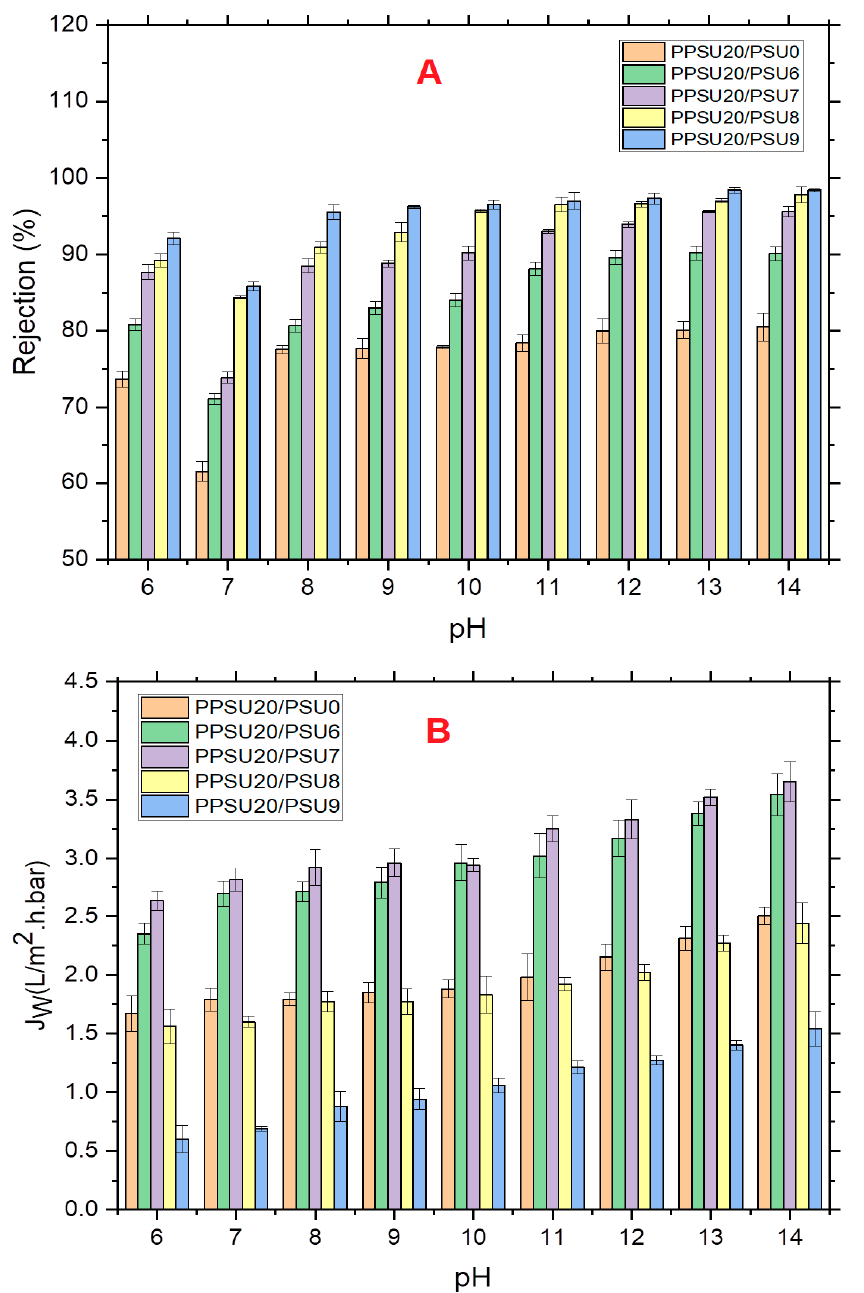
Figure 6. Blend membranes rejection ( A ) and permeation ( B ) using 10 − 4 M 4 ‐ NP (1 h, 25 °C and 3 bar).